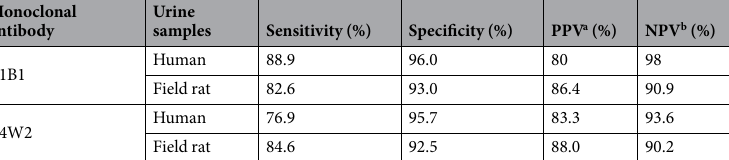
Table 1. Sensitivities, specificities, positive predictive values (PPV), and negative predictive values (NPV) for dot-blot ELISA using MAbs. a PPV, positive predictive value. b NPV, negative predictive